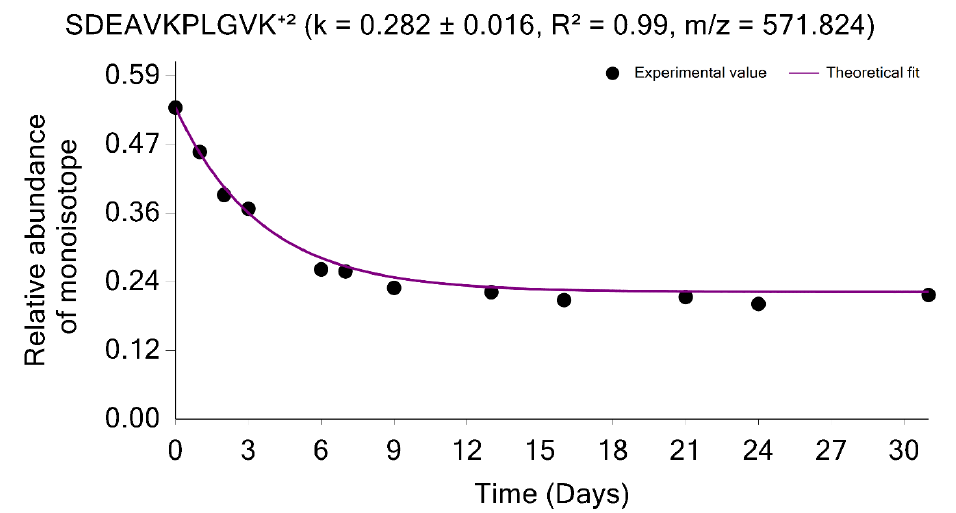
Figure 4. The graphical user interface enables comprehensive visualization of the results of protein turnover studies from metabolic D 2 O labeling and LC-MS experiments. Time series of monoisotopic RIAs (y-axis) are shown along the labeling duration ( x -axis). The solid line shows the fit from the computed degradation constant for SDEAVKPLGVK +2 peptide from FAS_MOUSE